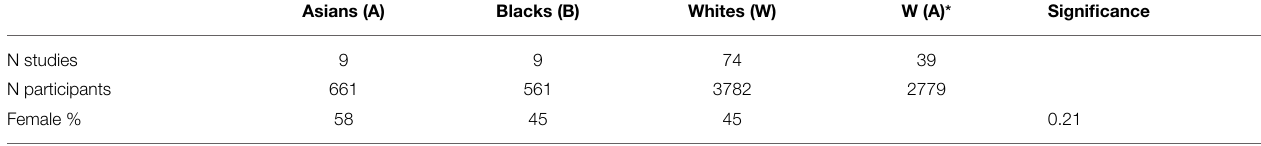
B vs. W: 0.04 B vs. W (A): 0.013 ( Figure 1 )